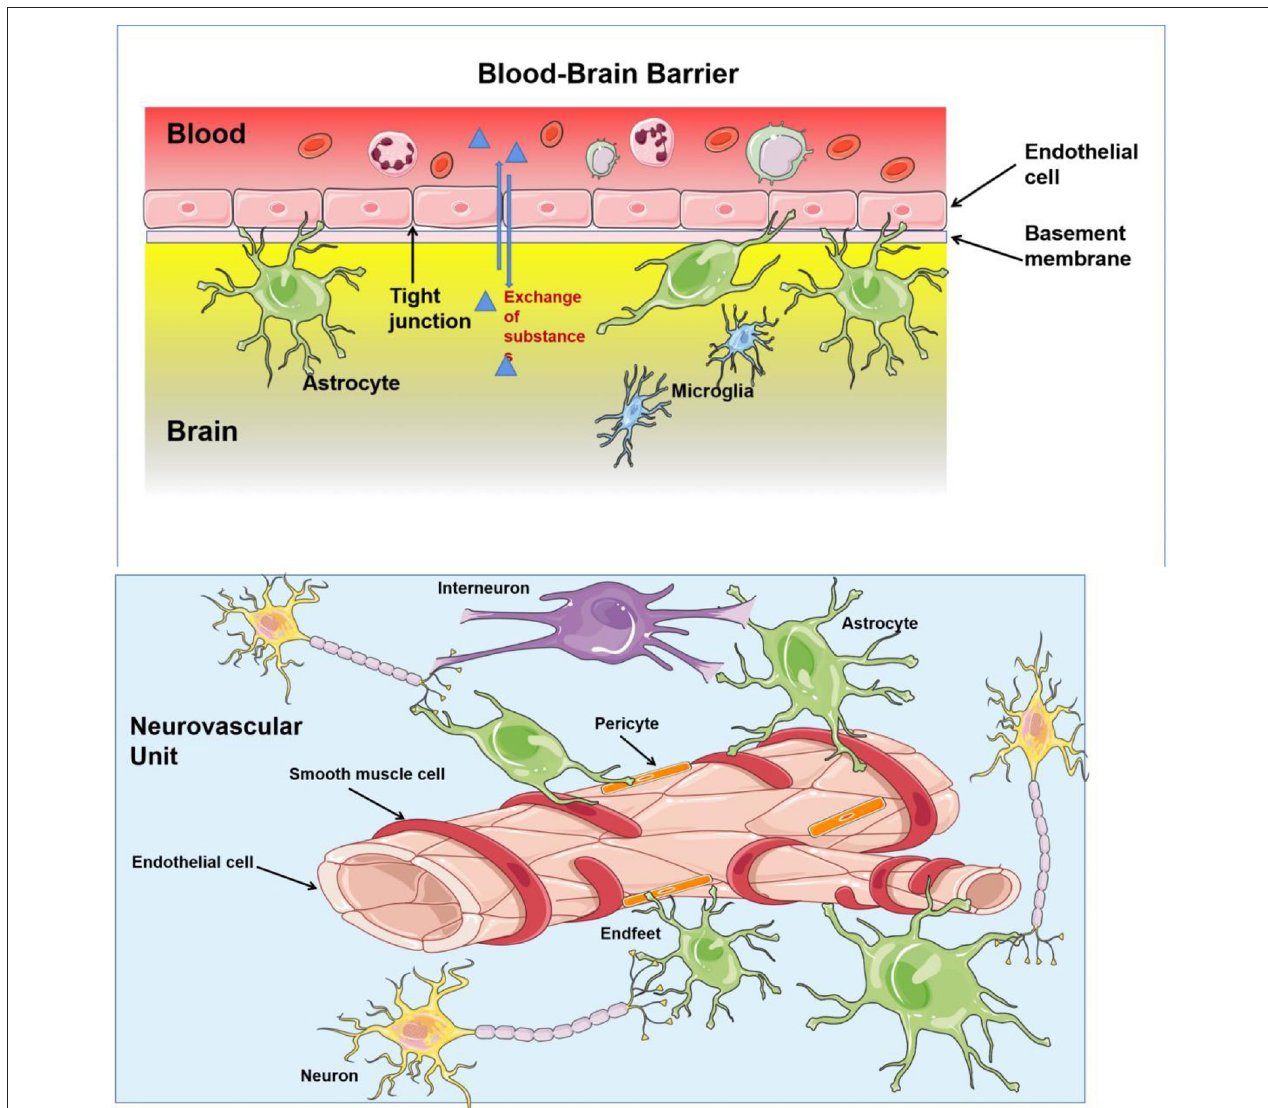
FIGURE 2 | The structure of blood–brain barrier (BBB) and neurovascular unit (NVU). BBB regulates substance influx and efflux to ensure a homeostatic environment for the brain function, which is composed by basement membrane, astrocytes, and endothelial cells (ECs) anchored to each others by tight junction. Neurones, interneurones, astrocytes, smooth muscular cells, pericytes, and ECs are important constituents of NVU, which provides a basic structure for NVC and regulates the cerebral blood flow